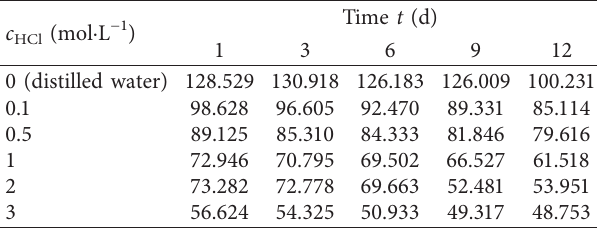
Table 4: Compressive yield stress σ different acid erosion concentration and time.